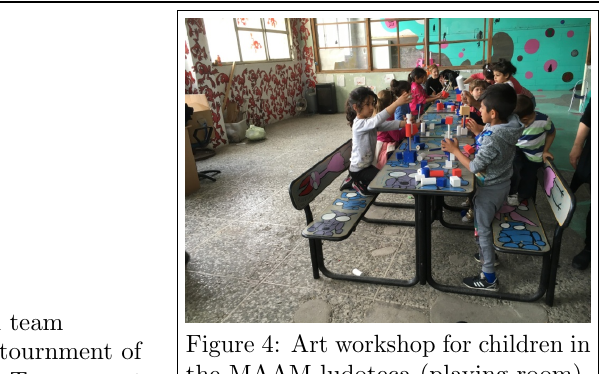
Figure 4: Art workshop for children